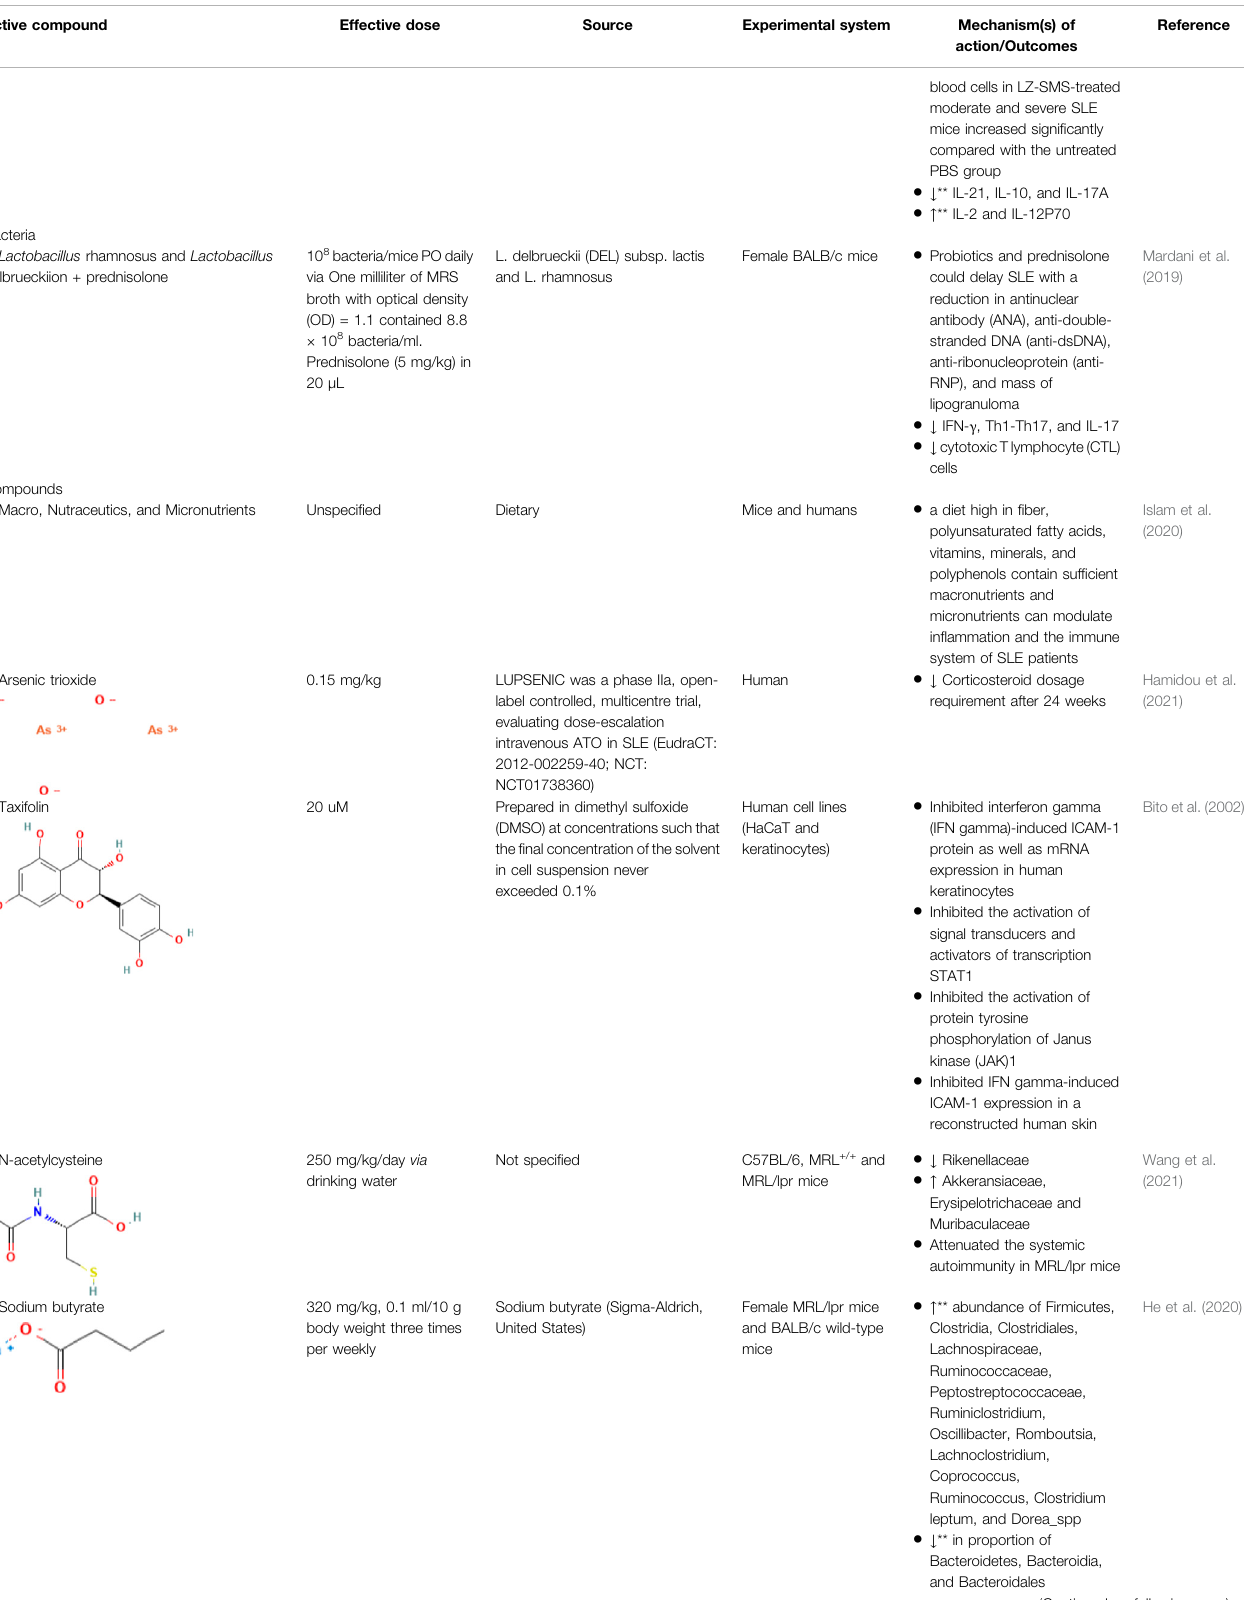
TABLE 1 | ( Continued ) Synthesized fi ndings for potential bioactive compounds for